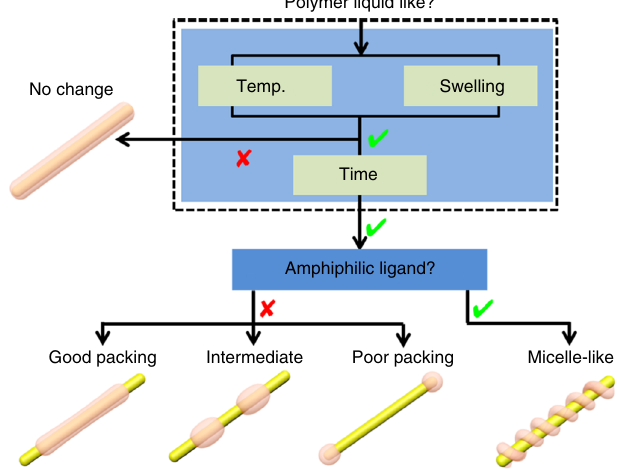
Fig. 4 Flow chart summarizing the determining factors. Ligand is the critical factor determining the modes of shell transformation, whereas excess ligand, high temperature, and time affect polymer